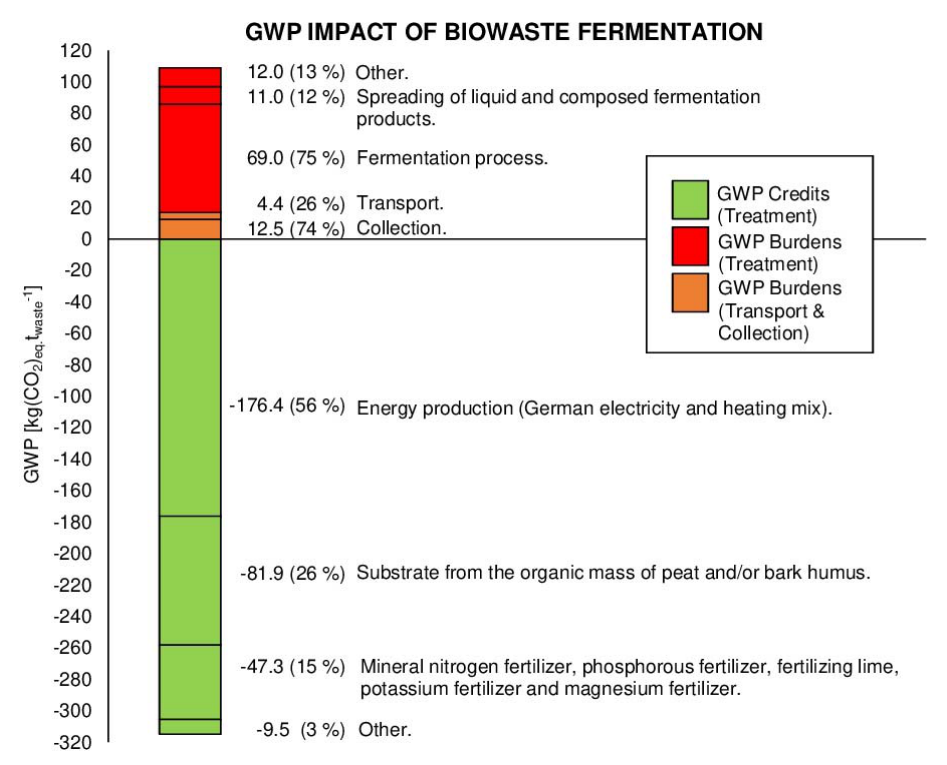
Figure 6. An overview of the environmental impact of biowaste fermentation expressed using GWP, via SEP ‐ BIO.